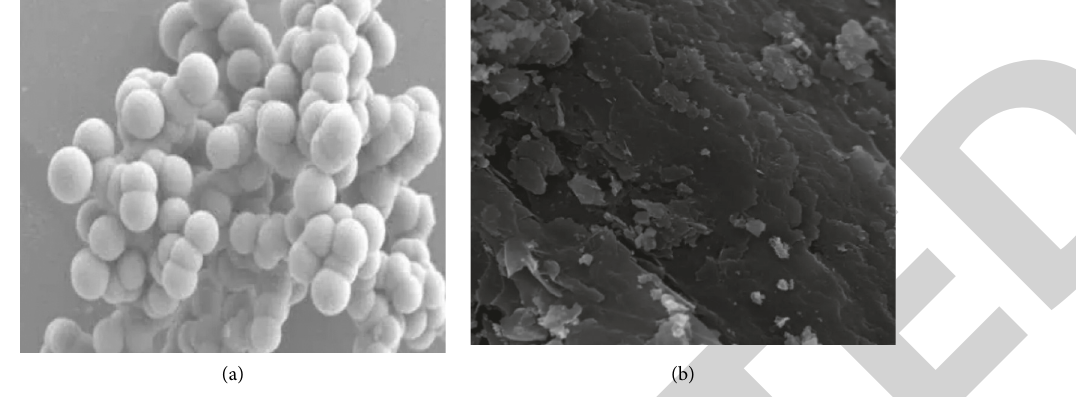
Figure 4: Scanning electron microscope image of the